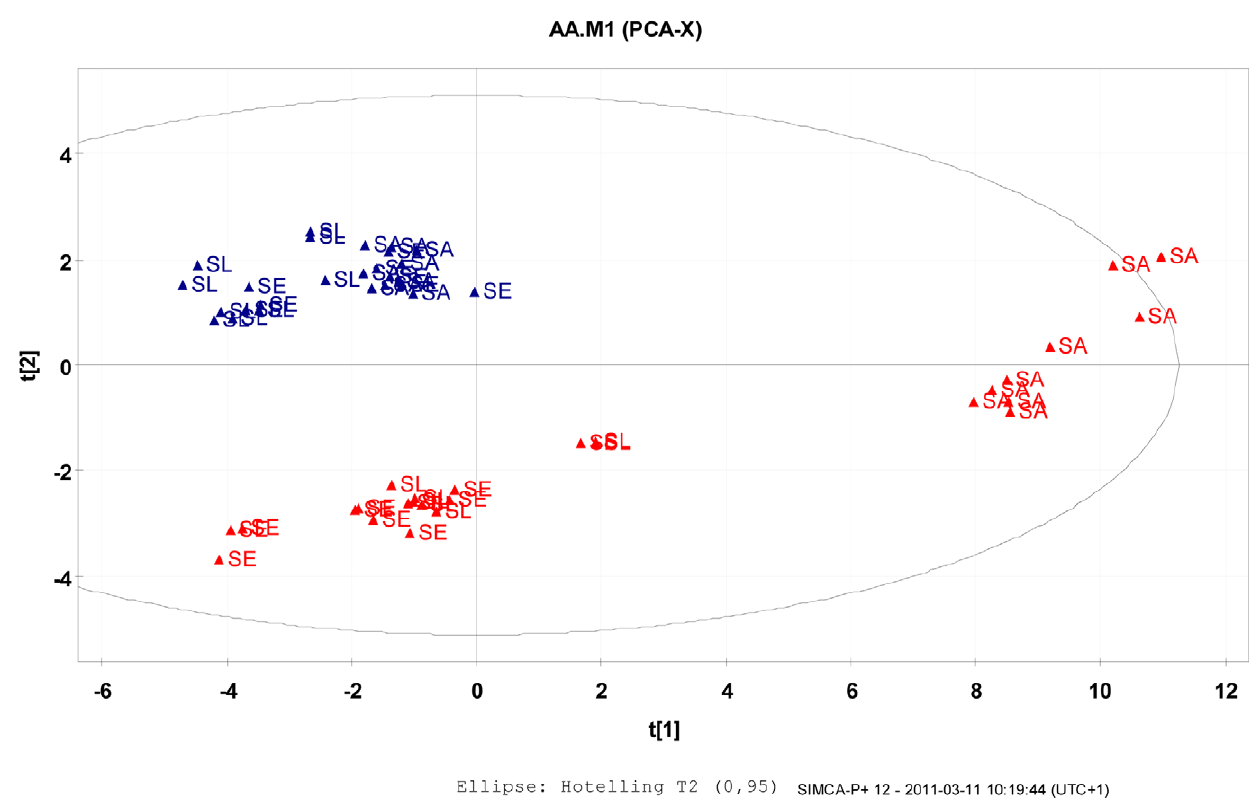
Figure 4. Principal Component Analysis (PCA) scores (t1 versus t2) scatter plotted from staphylococcal cell-wall amino acid profile data. The staphylococci cultures were grown under ideal conditions at 37 u C representing the reference control samples (Cont) or subjected to prolonged exposure to 4 u C for 8 weeks (TE) before sampling and amino acid analyses. Three different strains, S. aureus (SA), S. epidermidis (SE) and S. lugdunensis (SL) were investigated in replicates (n=9) for each strain for responses to the temperature